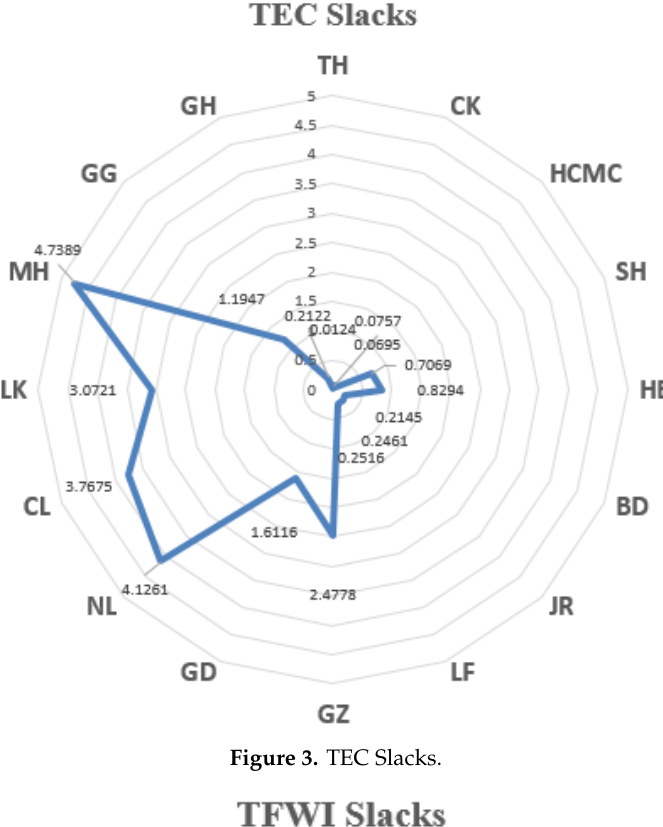
Figure 3. TEC Slacks.